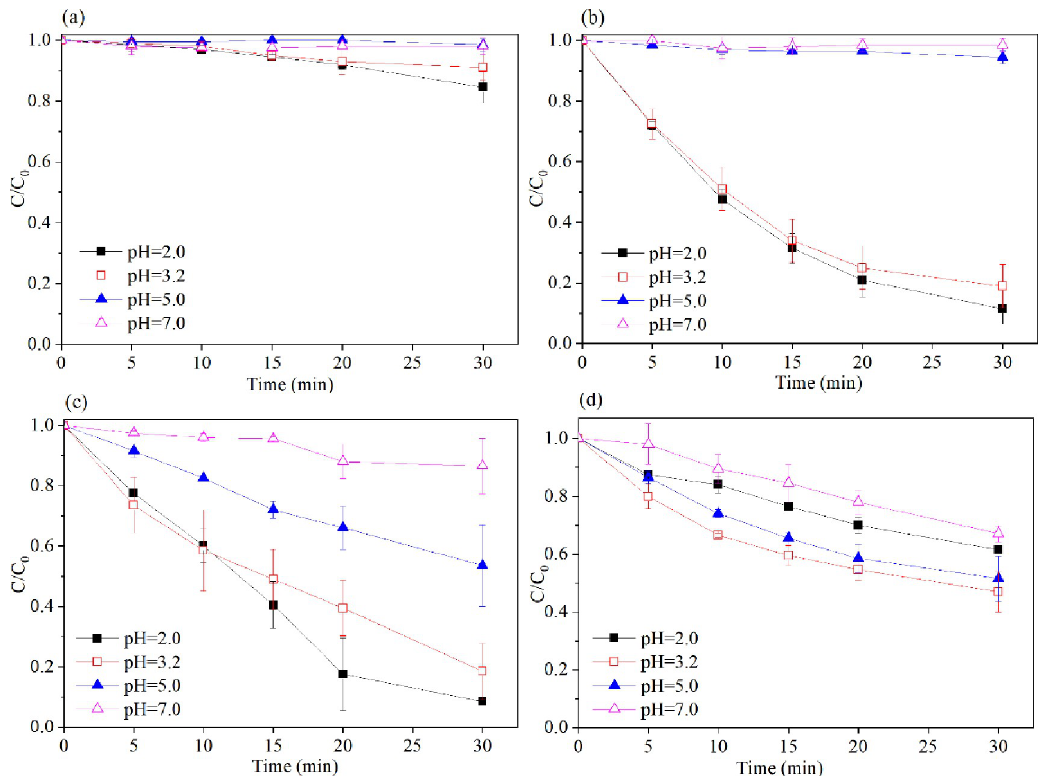
Fig 4. Effect of initial pH on the degradation of 2,4,6-TCP in four systems. (a) Fe 0 ; (b) Fe 0 /H 2 O 2 ; (c) Fe 0 /PMS; (d) Fe 0 /PS. Conditions: c(2,4,6-TCP) = 0.2 mmol•L -1 ; c(Ox) = 1 mmol•L -1 ; c(Fe 0 ) = 0.1